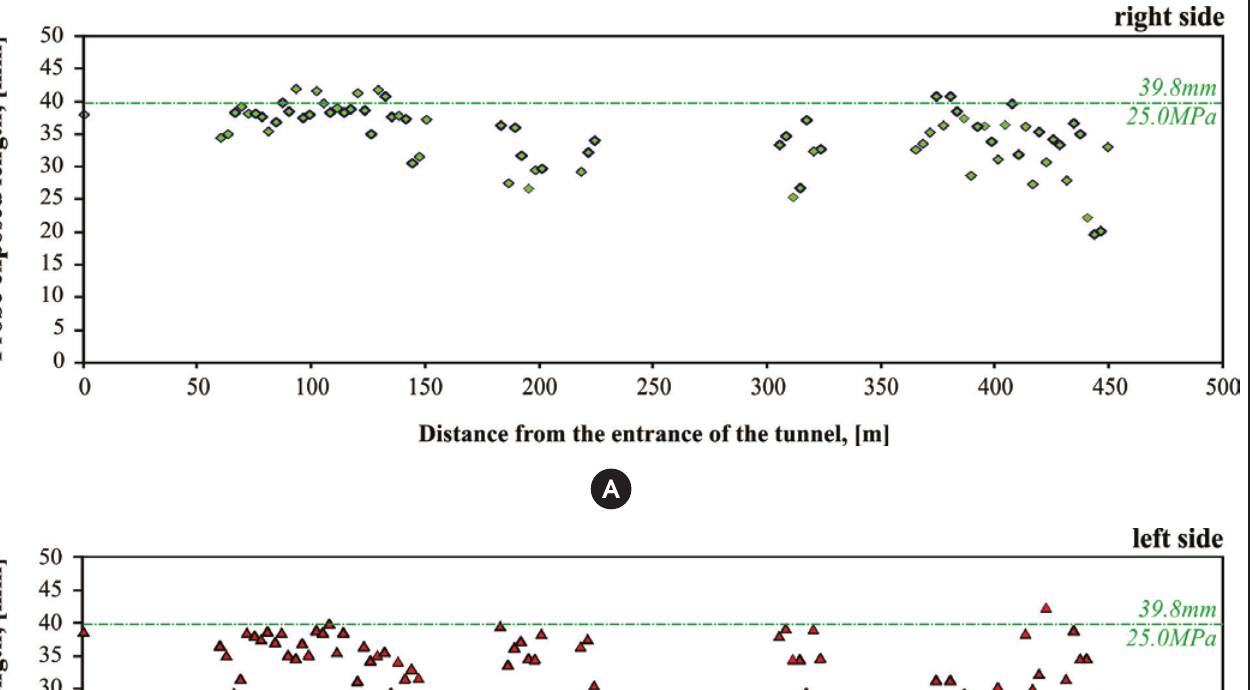
Figure 9 – Average length of the exposed pin for the following